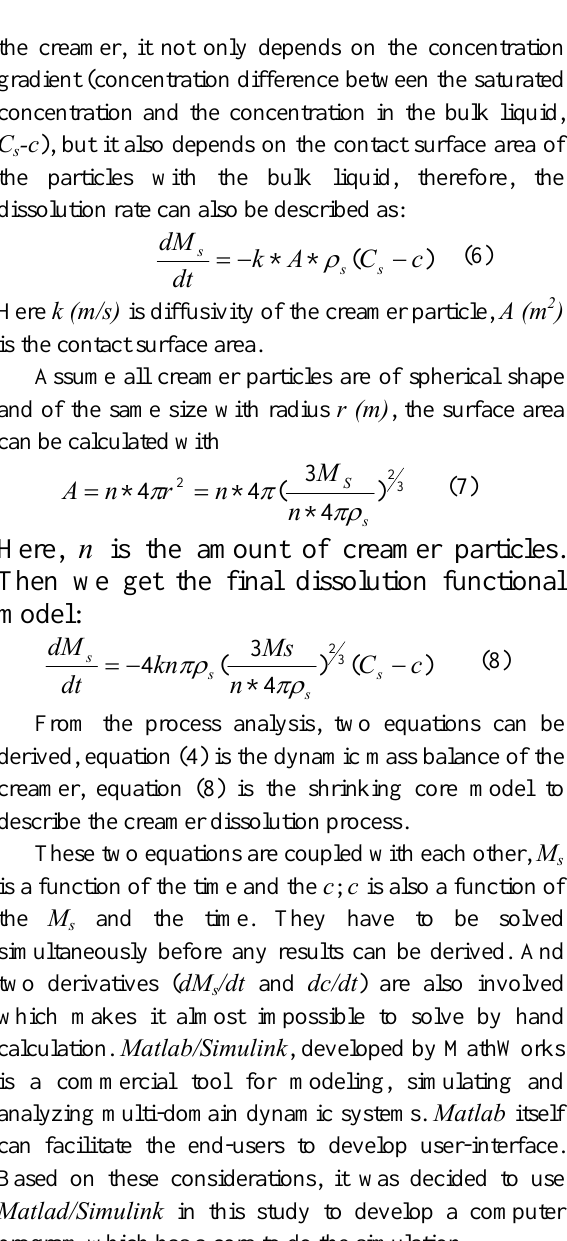
Fig. 5. Interface of the